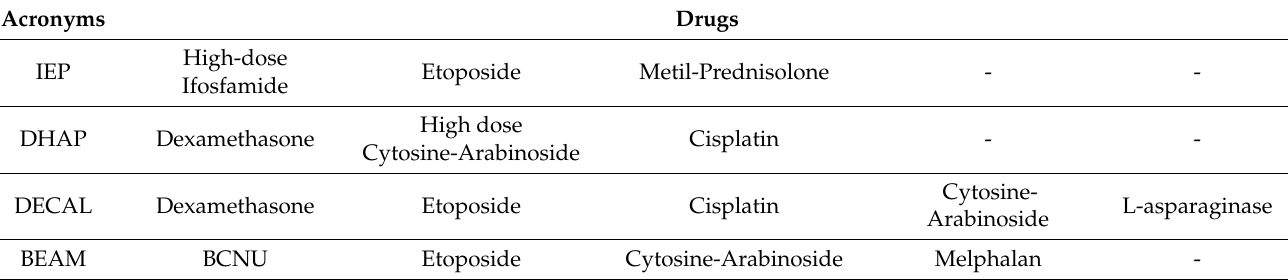
Table 2. Therapeutic regimens utilized as a second line treatment for